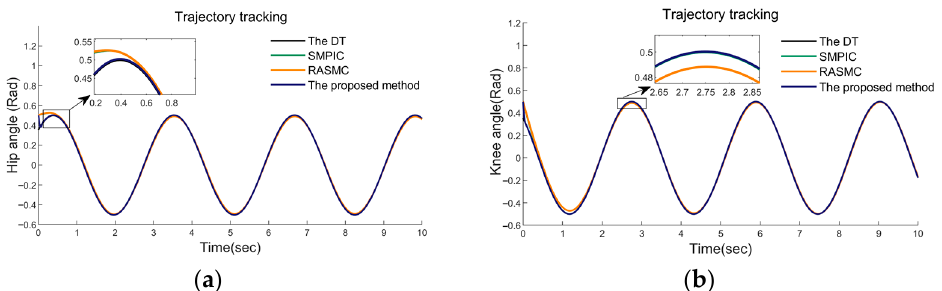
Figure 6. The tracking response of the joints. ( a ) the response of θ 1 under case 0 condition; ( b ) the response of θ 2 under case 0 condition.